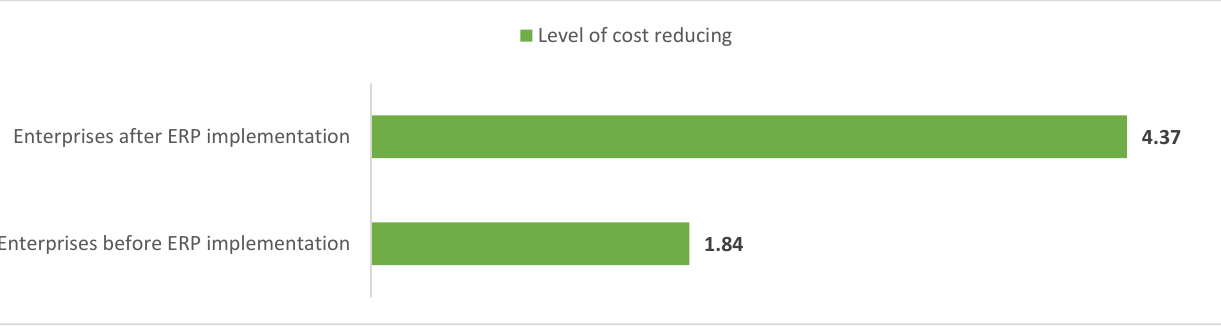
Figure 2. Levels of cost reductions in construction enterprises before and after implementation.